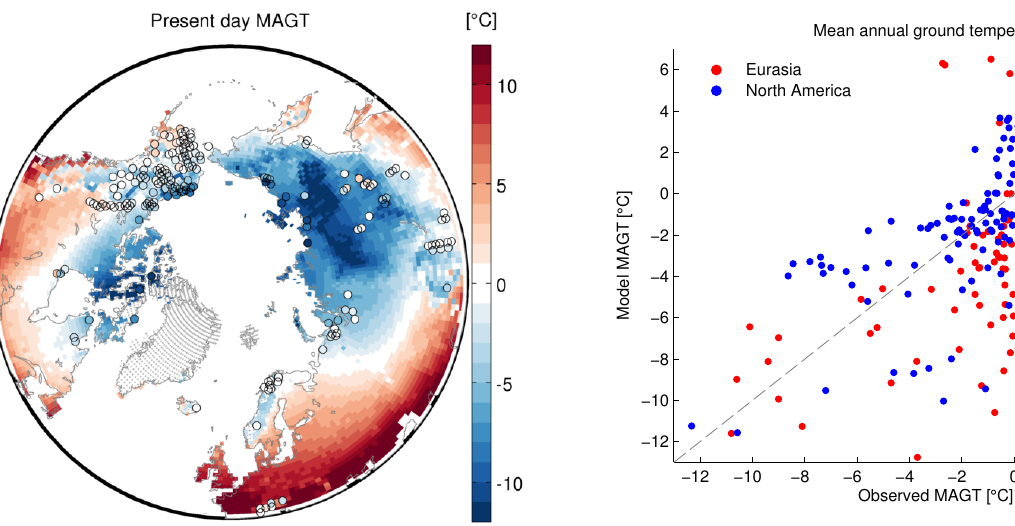
Figure 3. Comparison of present-day modeled mean annual ground temperature (MAGT) with site level observations from IPA (2010) and Romanovsky et al. (2010). Observations are represented by cir- cles with the filling color showing temperature. Grey dots indicate grid cells where the model simulates present-day ice sheet cover.